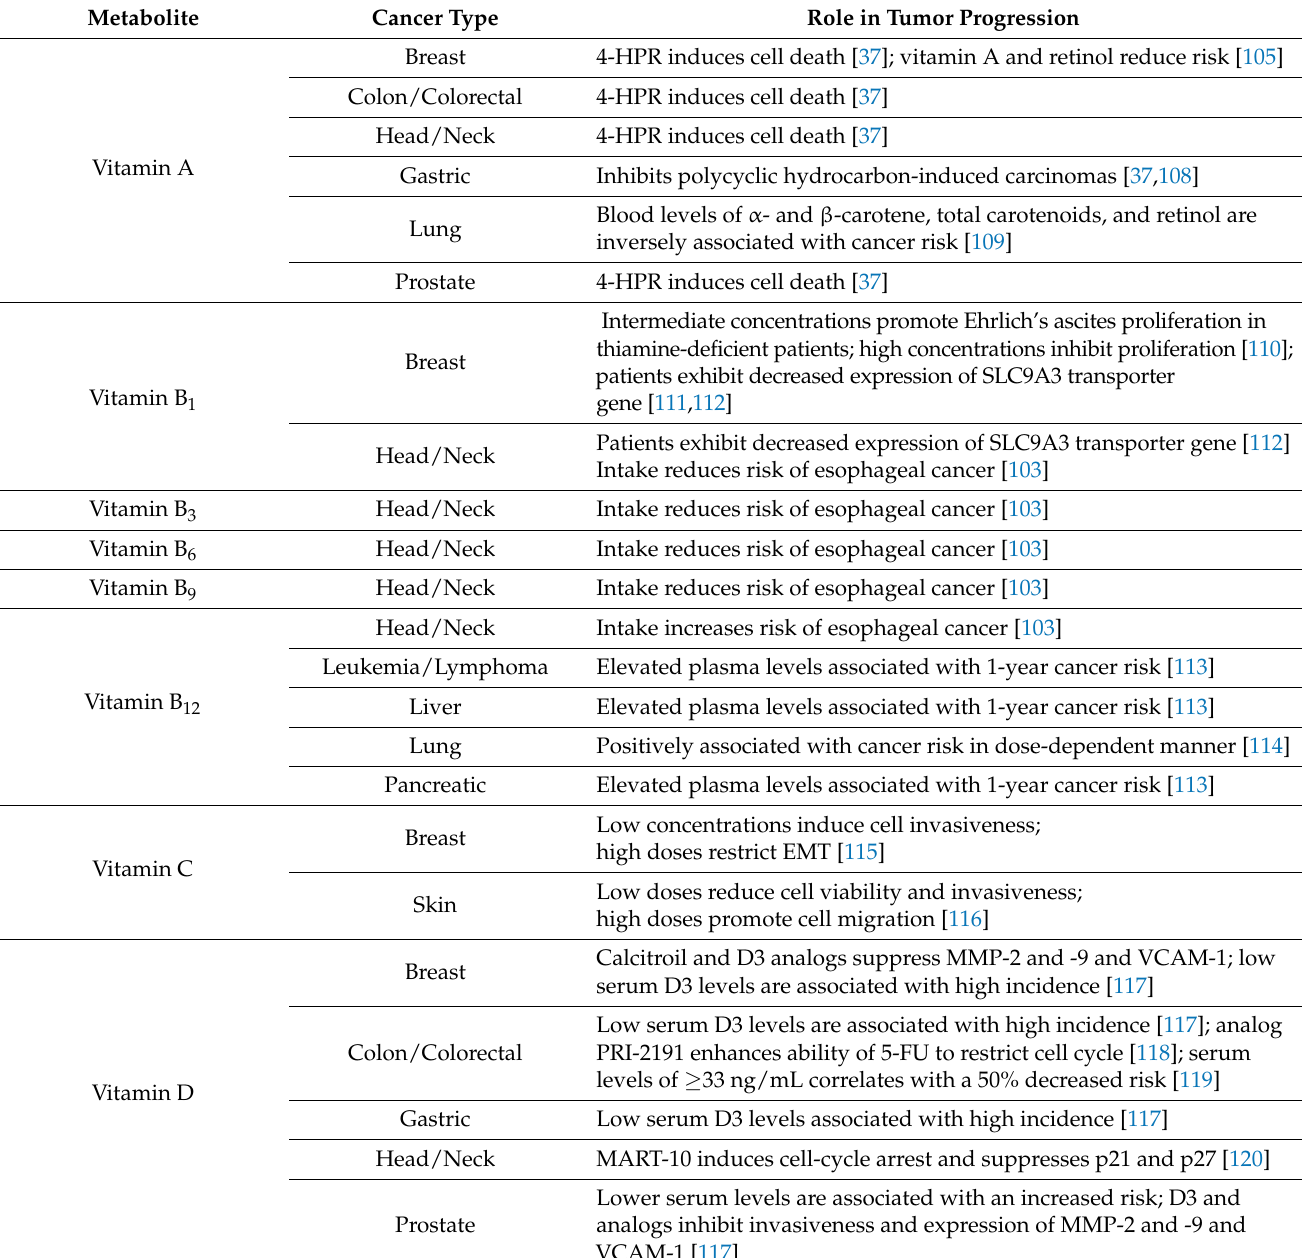
Table 1. Metabolite contribution to tumor survival varies between cancer